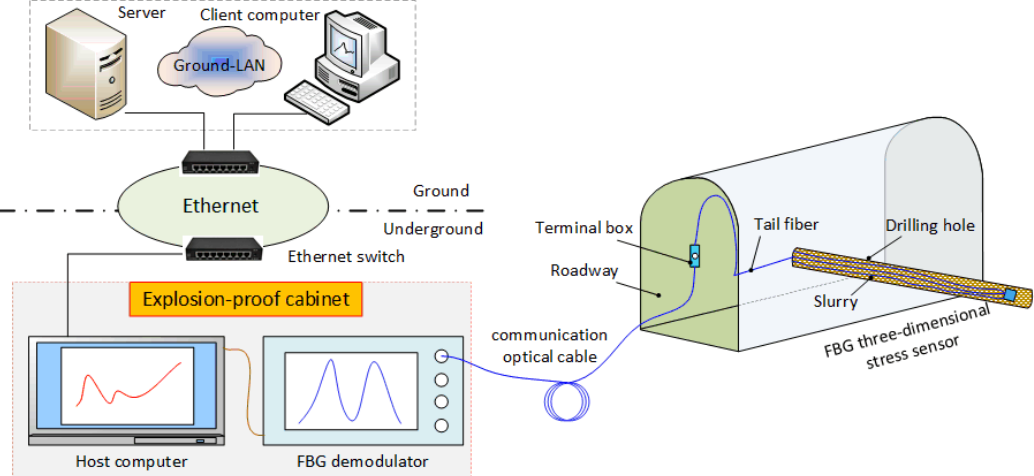
Figure 13. Schematic diagram of surrounding rock stress measurement.